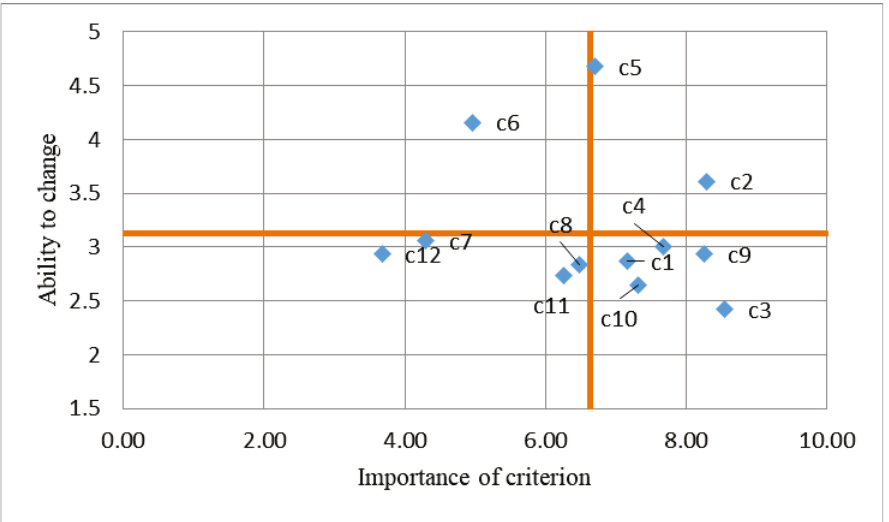
Figure 2. Dependency of the ability to change on the importance of the criterion (Stage 1).